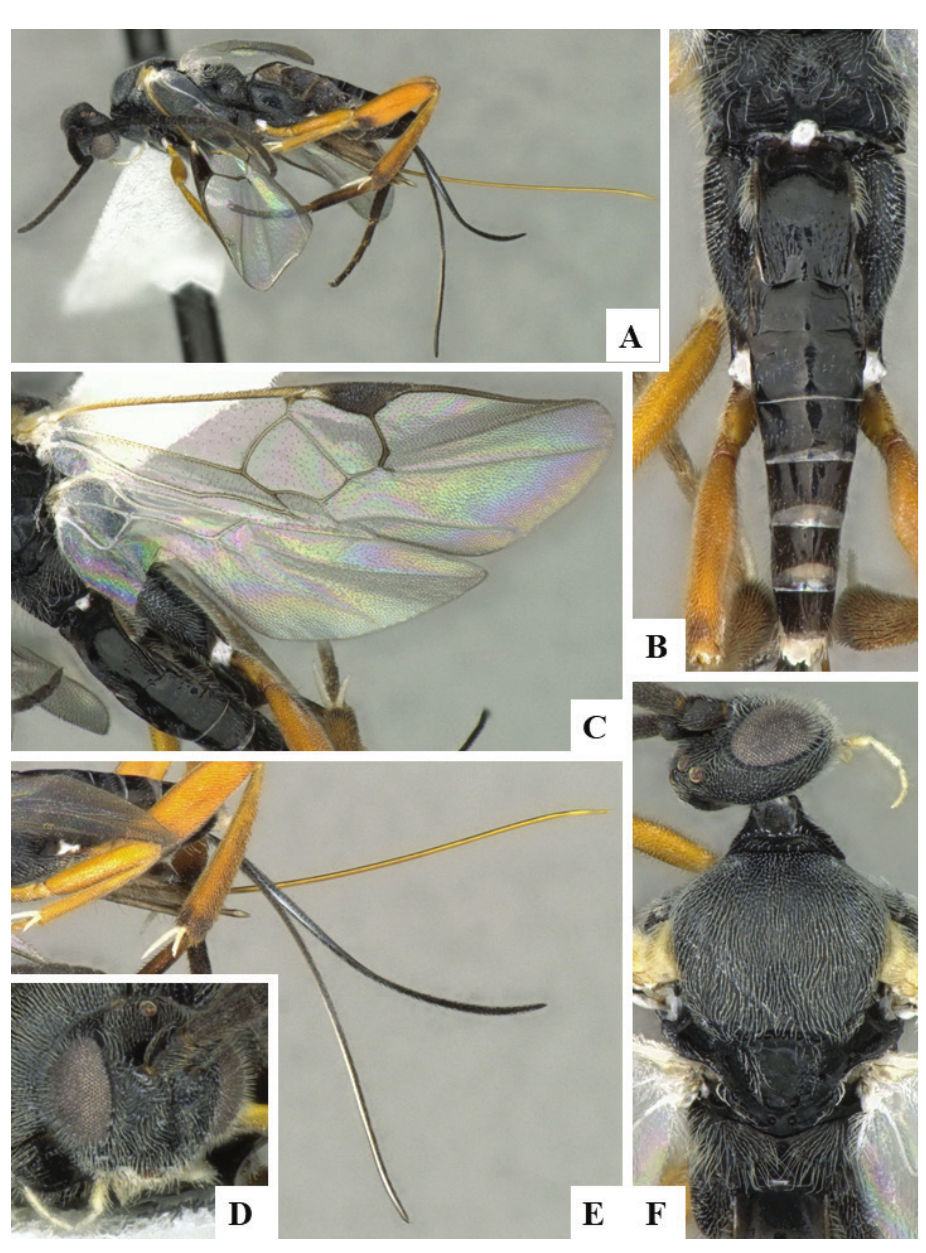
Figure 5. A–F Dolichogenidea josealfredohernandezi sp. n., holotype. A habitus, lateral B metasoma, dorsal C wings D head, dorsal E metasoma (partially), lateral F head and mesosoma,